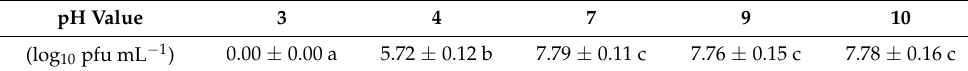
Table 5. Stability of the phage UAE_MI-01 under different pH values.